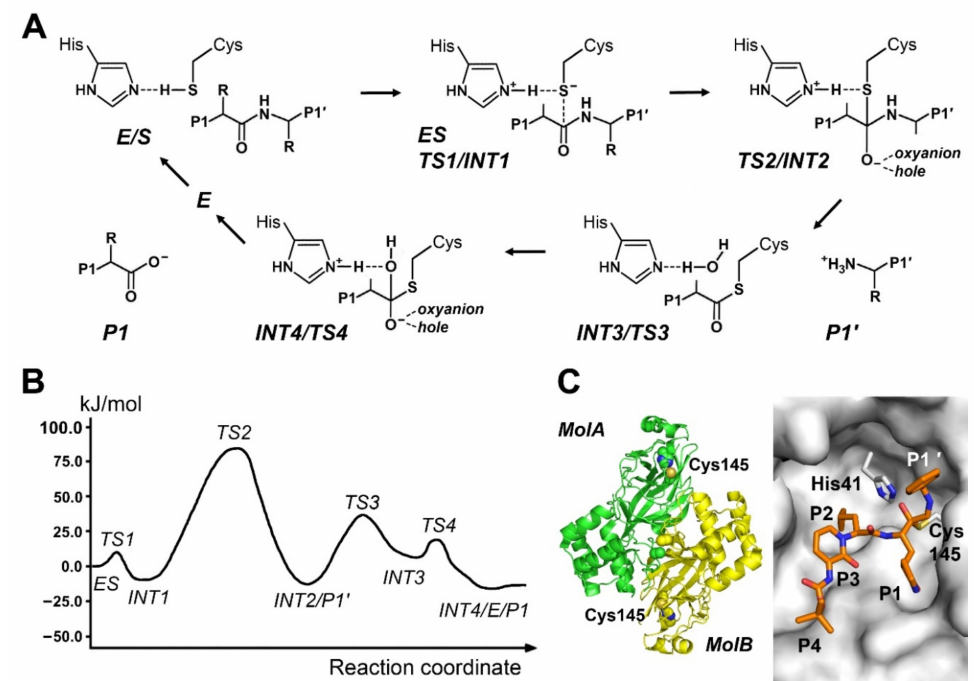
Figure 4. Mechanism of cysteine proteases. ( A ) As in the prototypic papain the catalytic residues of the dyad are a Cys and a His. Essentially two major reaction steps take place, namely the acylation and the deacylation, while several sub steps are involved, according to Wei et al. (2013) [99]. 1. Nucleophilic attack by the negatively charged S γ atom on the carbonyl C of the P1 residue (TS1) and formation of tetrahedral intermediate (INT1). The oxyanion hole stabilizes the negative charge at the carbonyl O atom. 2. Upon protonation of the amide NH group the scissile bond breaks and the P1 (cid:48) product leaves with a new N-terminus (TS2). 3. The acyl intermediate (INT2) is attacked by the nucleophilic catalytic water (TS3) and forms the second tetrahedral intermediate (INT3). 4. Release of the P1 product with a new carboxy terminus (TS4/INT4 and E/P1). ( B ) Free energy profile of the above described reaction. ( C ) The coronavirus SARS-Cov-2 main protease (M Pro ) is depicted as free enzyme dimer (PDB 6Y2E) on the left and with a covalent ketoamide inhibitor (PDB 6Y2G) as TS2 analog on the right. Some residues of the protease were omitted for